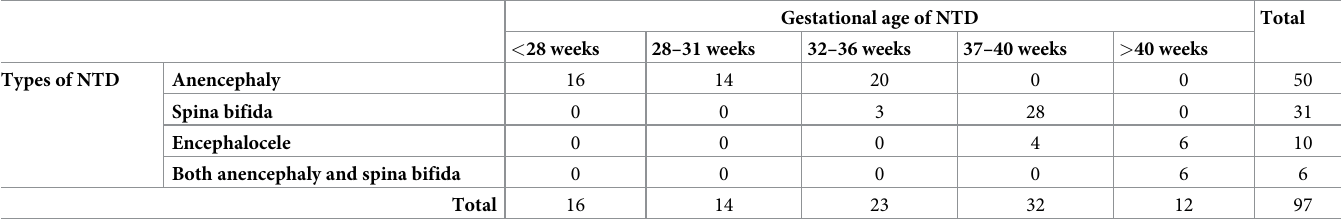
Table 3. Types of NTDs and gestational age at Debre Berhan Referral Hospital, North Shewa, Ethiopia, 2019. [N =